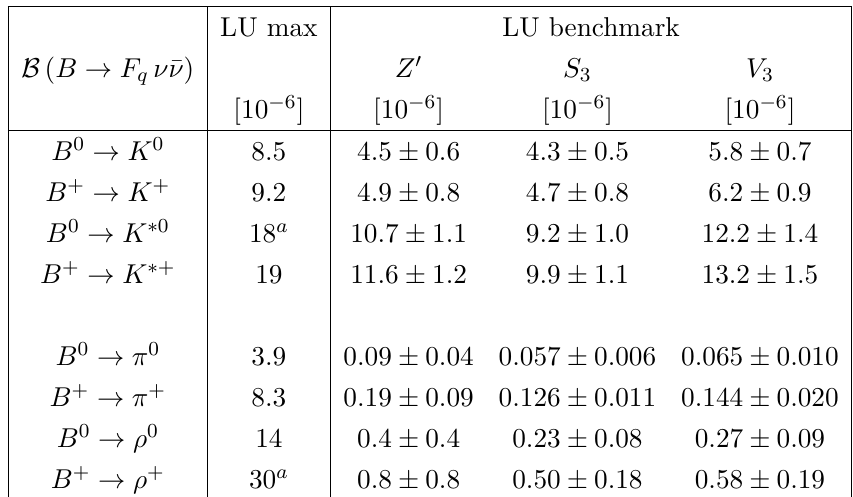
Table 5 . Maximally allowed lepton universal branching ratio by the LU limits (4.7), (4.8) as well as predictions in a Z 0 model as well as two leptoquark representations, S and b → d modes. a